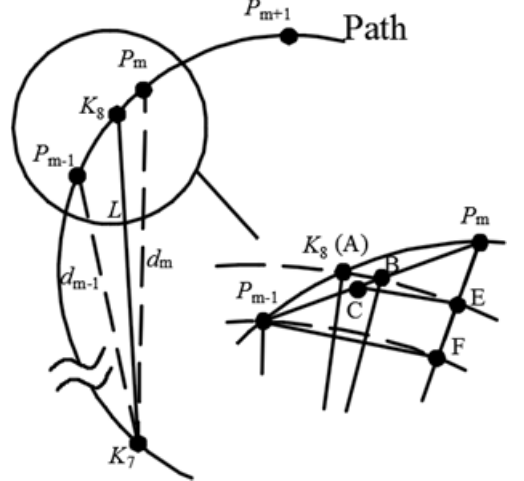
Figure 9. The interpolation method.